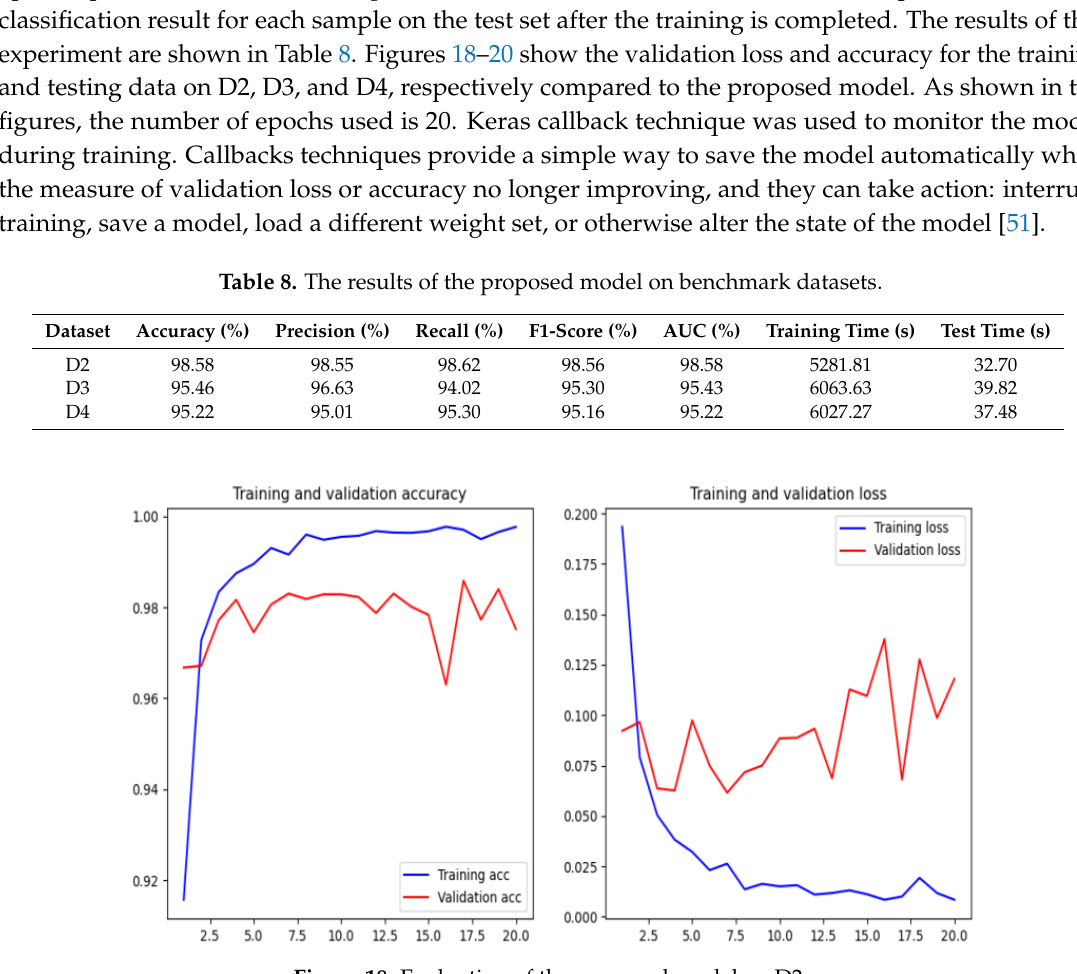
Figure 18. Evaluation of the proposed model on D2.